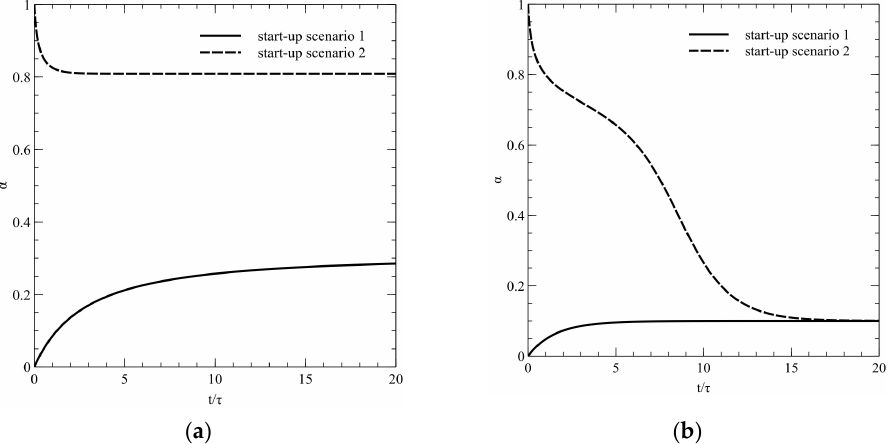
Figure 4. Dynamical simulations of reactor start-up for Da = 10. The absorbance was equal to: ( a ) 4.5; ( b ) 5, respectively